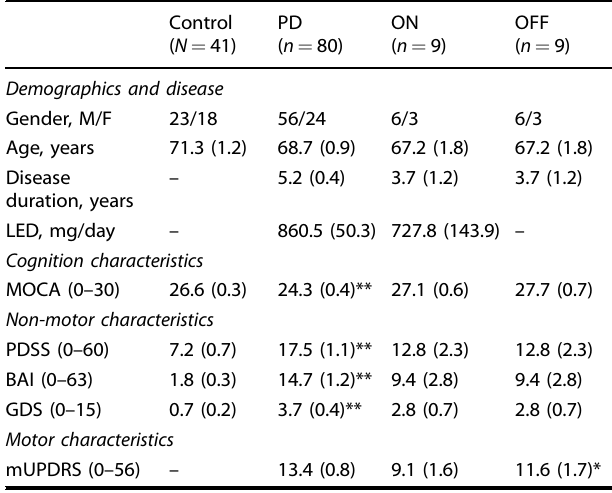
Table 2. Demographic, disease, non-motor, motor, and cognitive